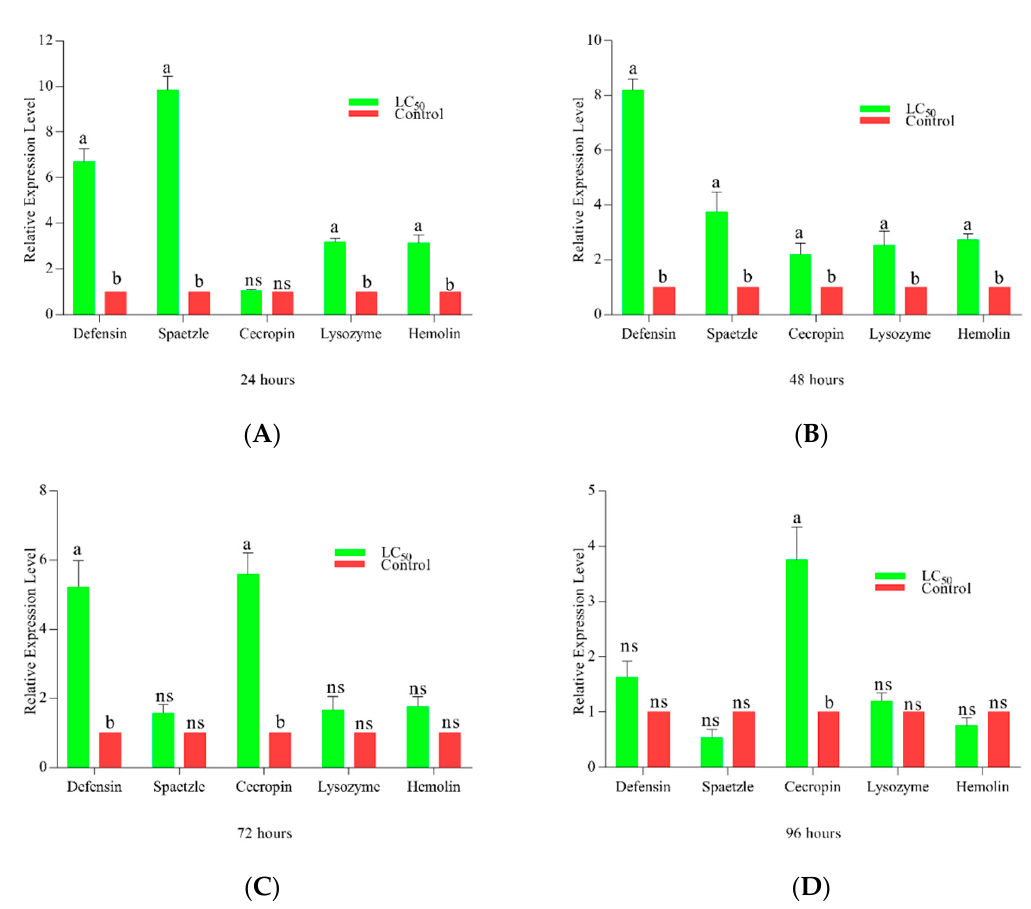
Figure 5. Immune genes expression in Plutella xylostella against LC 50 of Metarhizium anisopliae . Time-dependent activity is shown in the figure, the green color bar shows the activity of gene at LC 50 of M. anisopliae while the red bar shows the control. ( A – D ) shows the activities of enzymes after 24, 48, 72, and 96 h respectively. Error bars show 95% confidence intervals (CI). Letters indicate significant differences at p < 0.001. (ns = non-significant).